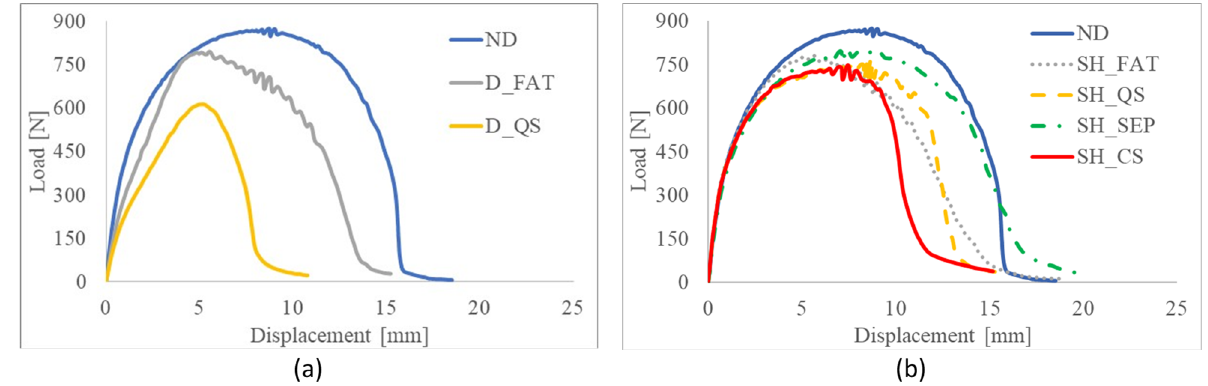
Figure 2. ( a ) Comparison among the undamaged and damaged SLJ tests; ( b ) comparison among undamaged, healed, and rebonded SLJs.